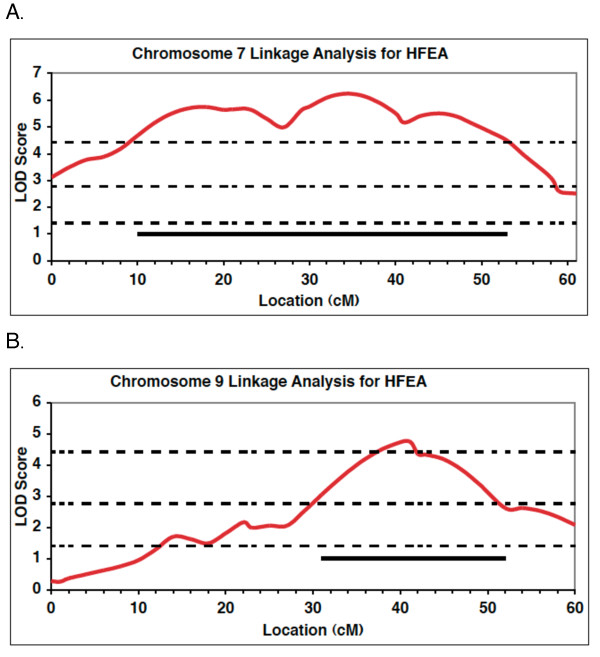
Interval maps of HFEA QTLs on chromosomes 7 and 9. Interval mapping plots for QTL affecting the HFEA trait on (A) chromosome 7 and (B) chromosome 9 in the C3H-N2 population. Dashed lines indicate the permutation derived genome-wide significance levels for suggestive, significant, and highly significant linkage. Bars indicate the 1.5 LOD support interval.